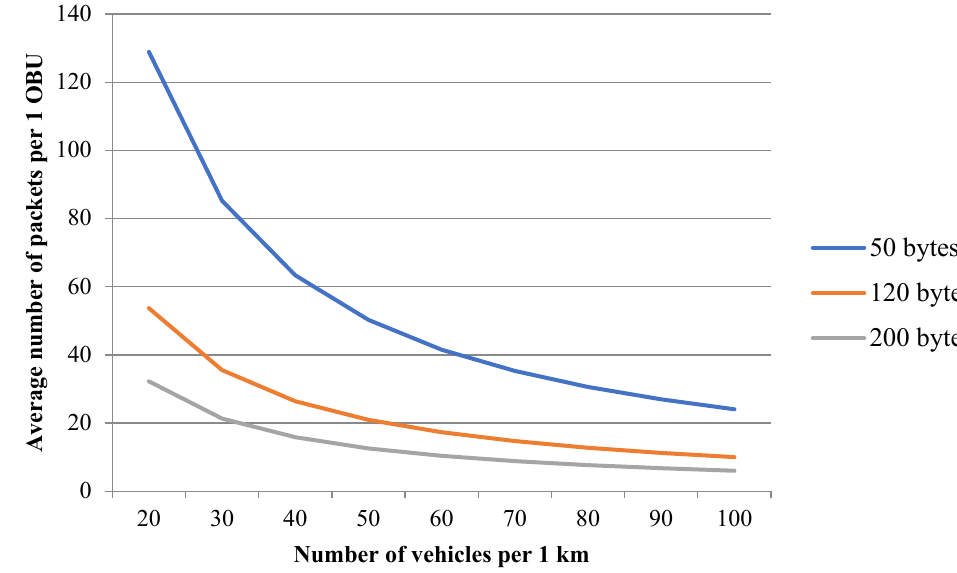
Figure 5. The average number of packets per OBU at the 1st confidentiality level.